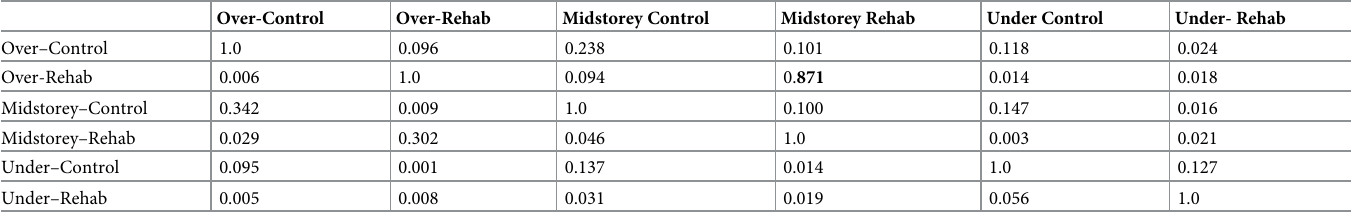
Table 3. Jaccards and Bray-Curtis similarity indices among species in the overstorey, midstorey, and understorey of reclaimed (rehabilitated) and control (neigh- bouring natural forest). Values above the diagonal represent Jaccard’s indices and values below the diagonal are Bray-Curtis values. Values in bold indicate high similarity between site-stratum types.